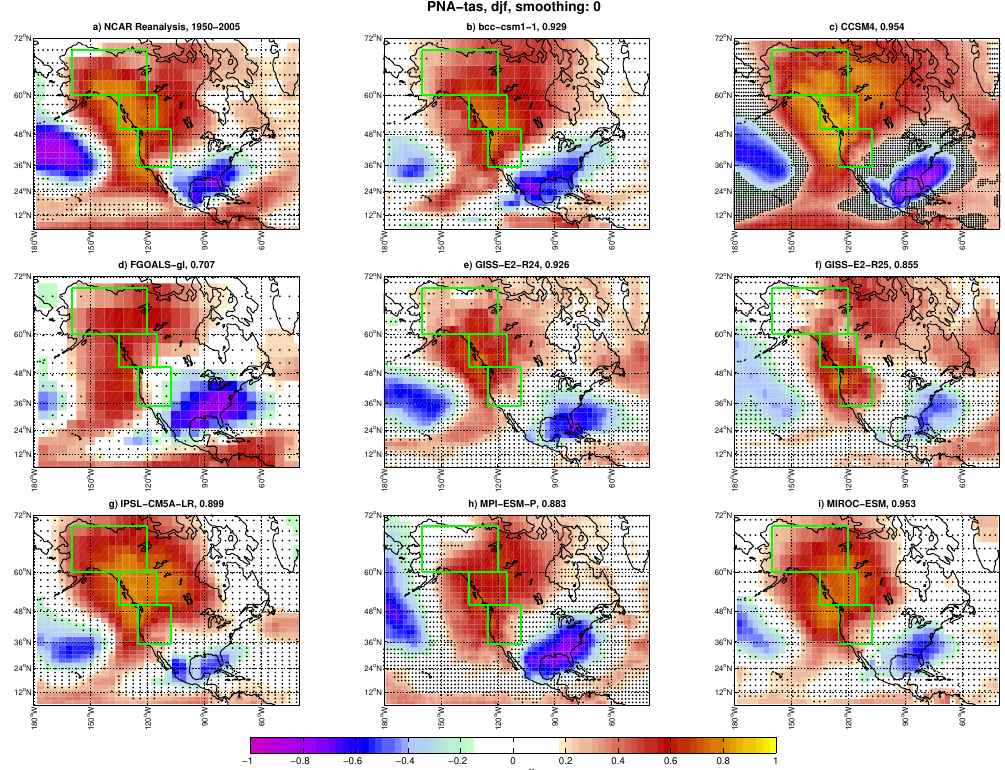
Figure 2. Observed and simulated correlation maps between the winter PNA index and winter surface air temperature time series for the period 1950–2005. Dots mark grid points where the correlation is not significant at 95% confidence accounting for autocorrelation. The green boxes mark the areas used for the TT2010 reconstruction. In panels (b–i) , the numbers reported in the respective titles are the spatial correlations between observed and simulated patterns calculated for the shown land-only domain north of 12 ◦ N (to this end, NCAR data were regridded to the model